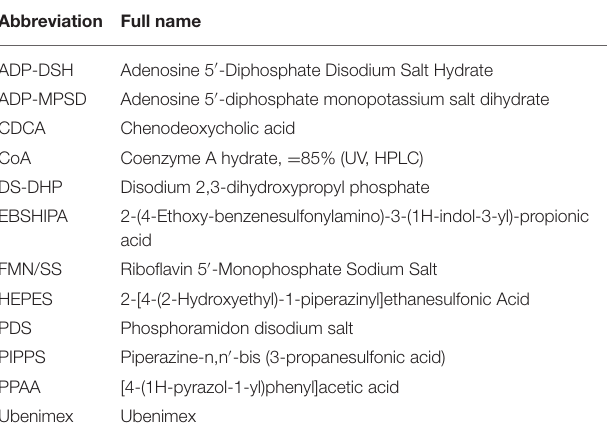
TABLE 1 | The twelve in silico selected compounds predicted to inhibit